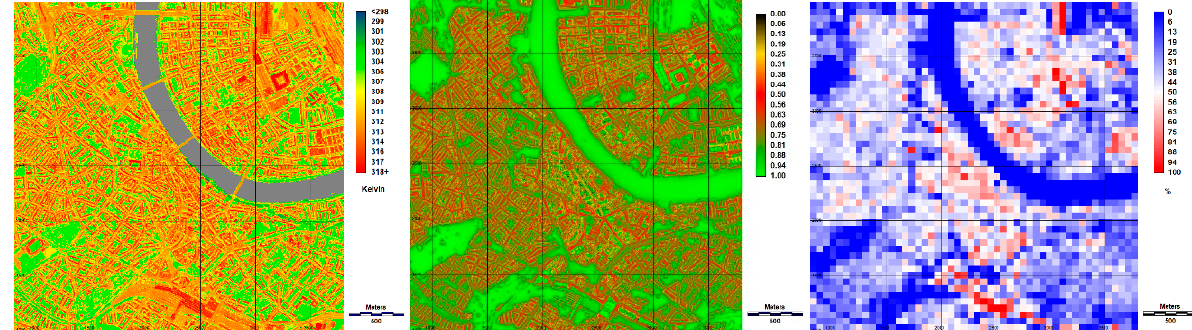
Figure 5. Surface temperatures of the city of Basel, Switzerland ( left ), from 1 m TIR airborne data, a sky-view factor in 1 m resolution ( center ), and percentages of roof surfaces at Landsat-ETM-LST-resolution (60 m) ( right ) [28].